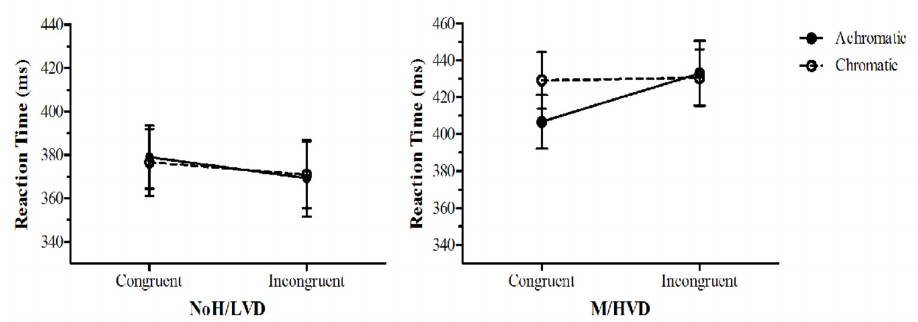
Figure 8. Group, Colour and Congruency effects for control conditions two and five. RTs were averaged over 12 repeat trials. The error bars represent ± 1 SEM